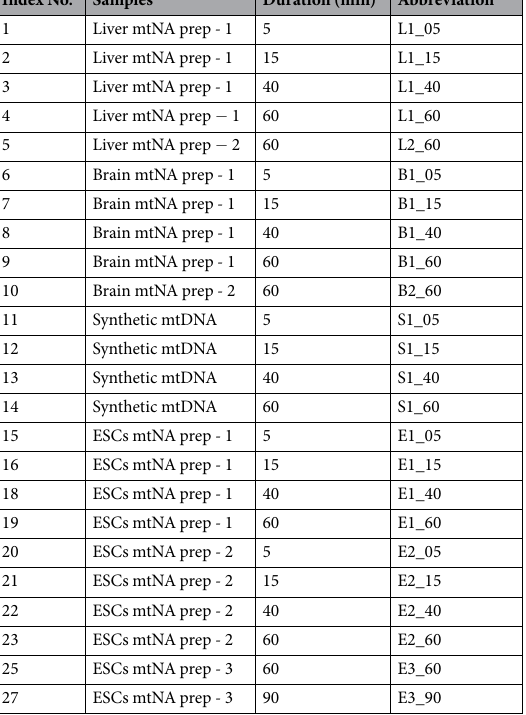
Table 1. Sample list of MiSeq analysis. Samples analysed were three independent preparations of ESC mtNA, two independent preparations of liver mtNA, two independent preparations of brain mtNA and a preparation